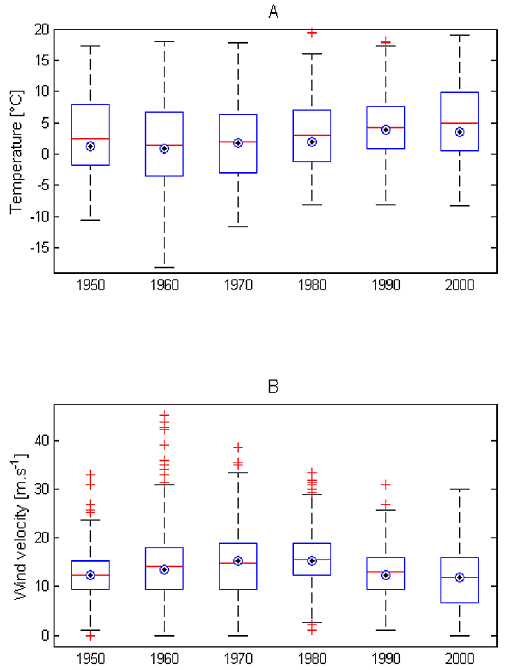
Figure 5. Temperature (a) and wind velocity (b) for dust events in the southern part of Iceland, 1949–2011. The boxes demarcate the range in which half the data can be found. The red lines represent the mean and the circles the median. Red crosses are extreme data points, outliers, which exceed the 25 or 75% quantile lines (quantile line extends maximally to 1.5 height of the central box).